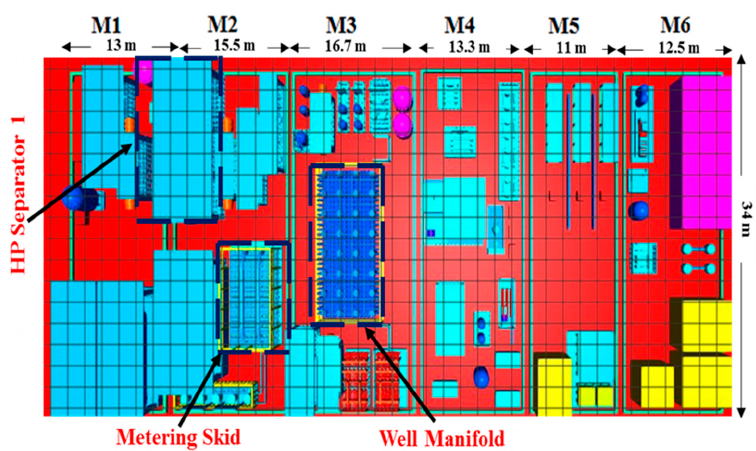
Figure 15. Most dangerous areas in terms of human fatality risk.